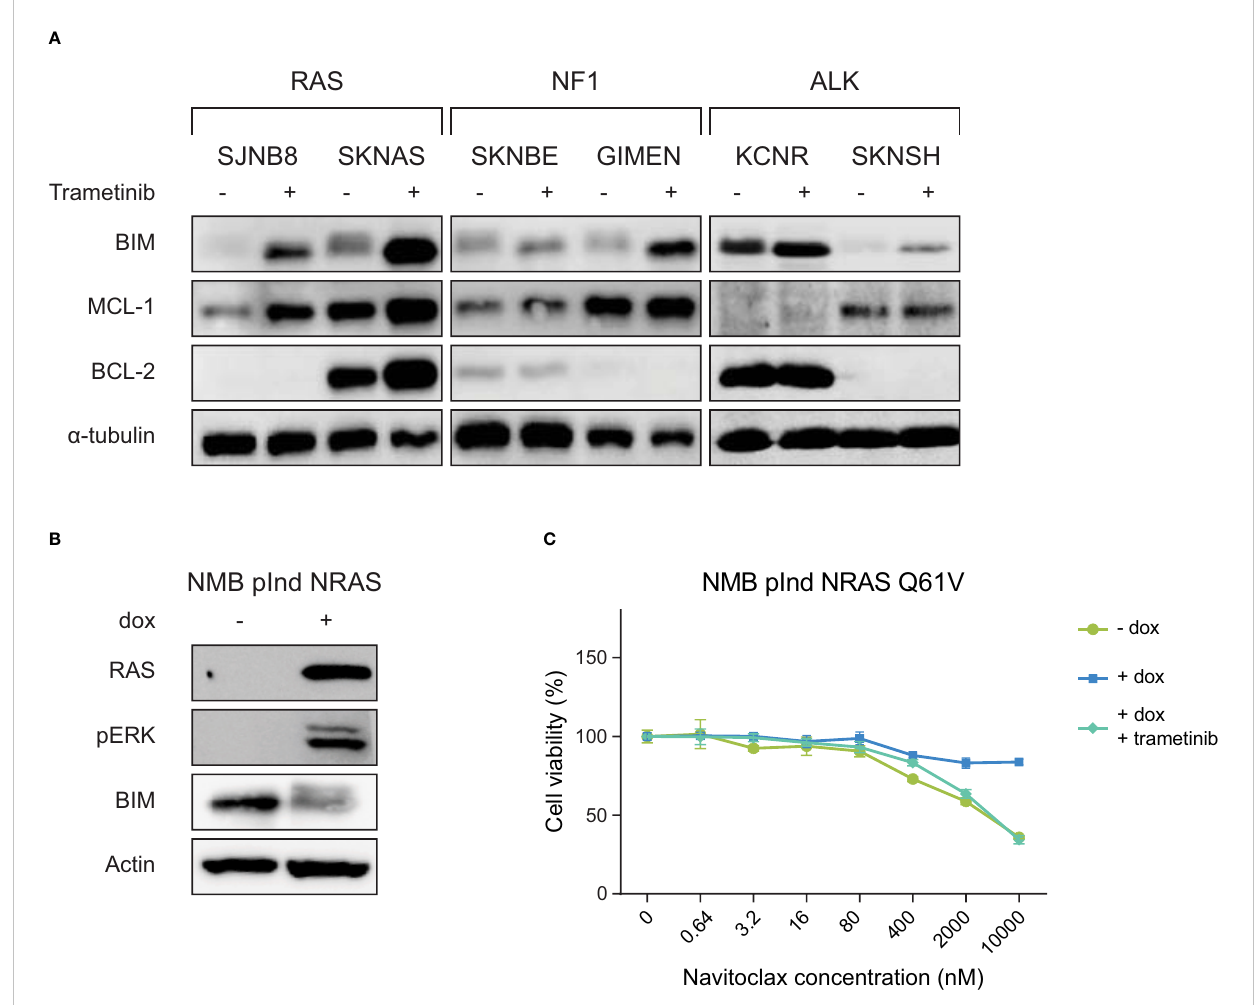
FIGURE 2 RAS-MAPK activation induces BIM destabilization and resistance to navitoclax, which can be inhibited by the MEK inhibitor trametinib. (A) Western blot of cell lines treated with DMSO or 1 µM trametinib for 6 h. Cell lines are grouped based on their mutation status of RAS-MAPK-associated genes. (B) Western blot of the inducible NRAS Q61V overexpression construct in the cell line NMB. (C) Navitoclax dose-response curves of NMB lines with inducible overexpression of NRAS Q61V with and without